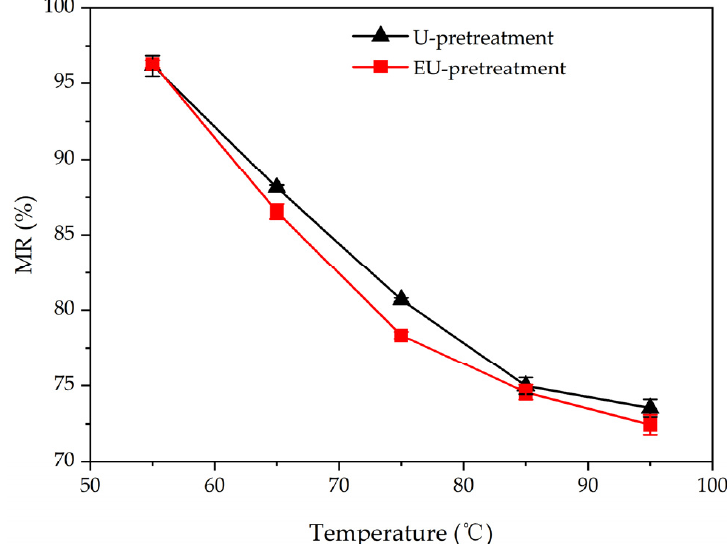
Figure 4. Effect of hot air drying temperature on moisture of Ginkgo fruits.